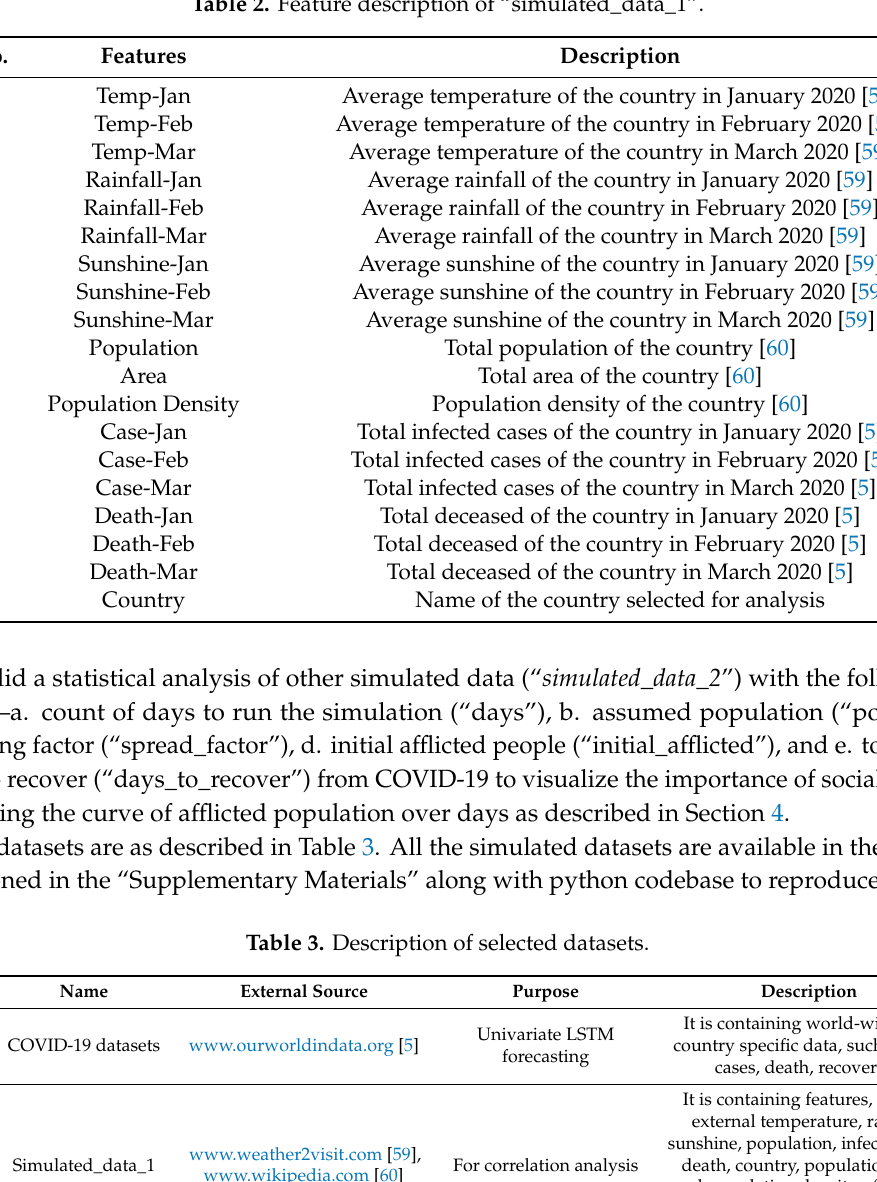
Table 2. Feature description of “simulated_data_1”.